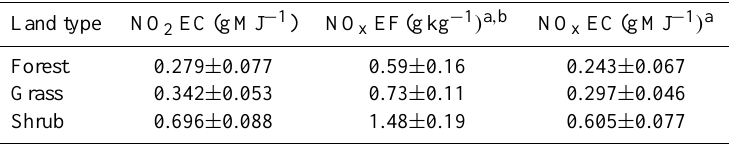
Table 1. NO 2 and NO x ECs and NO x EFs by fuel type.